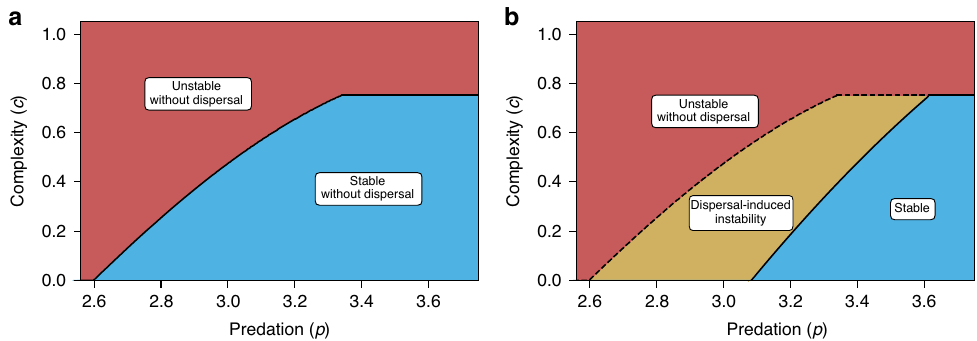
Fig. 3 Dispersal as a destabilising in fl uence. Panel a shows the stability diagram for the non-spatial ecosystem model with trophic structure. The solid line is the upper bound on complexity c for the equilibrium to be stable. Increasing complexity leads to instability. There is also a lower bound on the amount of predation p required for the community to be stable (if p is too small, then the equilibrium is unstable even for small values of the complexity). Stability for the spatial ecosystem with dispersal is shown in panel ( b ). In the blue region, the equilibrium is stable. In the yellow region, the equilibrium would be stable in a non-spatial model but dispersal in space induces instability. Crossing from the blue into the yellow region in panel ( b ) the ecosystem undergoes a Turing instability. In the red region in ( b ) the equilibrium is unstable both in the non-spatial and in the spatial ecosystem.